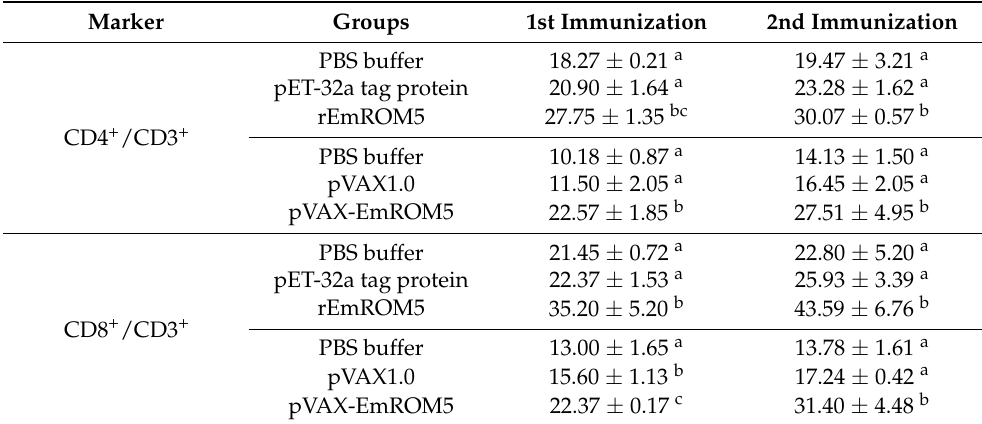
Figure 3. Transcription and expression of pVAX–EmROM5 in the injected muscles in chickens. ( A ) Transcription detection of pVAX–EmROM5 in the injected muscles by RT-PCR. M, DNA molecular weight standard of DL5000. Lane 1, PCR product of EmROM5 (1461 bp) from pVAX–EmROM5 injection site muscles. Lane 2, pVAX1.0 injection control. Lane 3, non-injected control. ( B ) Expression detection of EmROM5 in the injected muscles by WB. M, protein standard molecular weight. Lane 1, recognition of EmROM5 (53.57 kDa) in pVAX–EmROM5-injected muscles by anti-rEmROM5 rat serum. Lane 2, negative rat serum control. Table 4. Quantification of T lymphocyte subpopulations in spleen seven days after immunizations ( n = 5, value = mean ± SD).